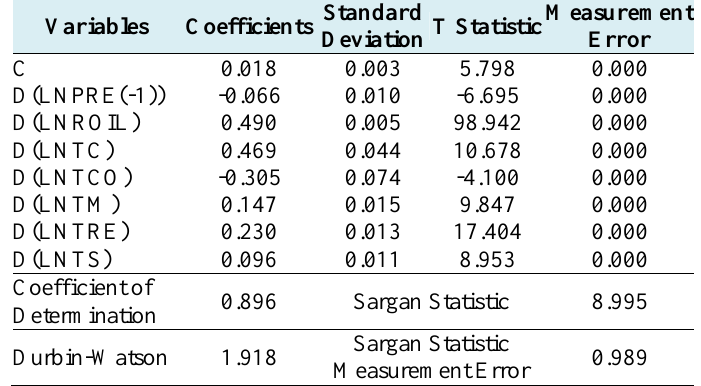
Table 3. Estimation of Research Model by Generalized Torque Method Variables Coefficients